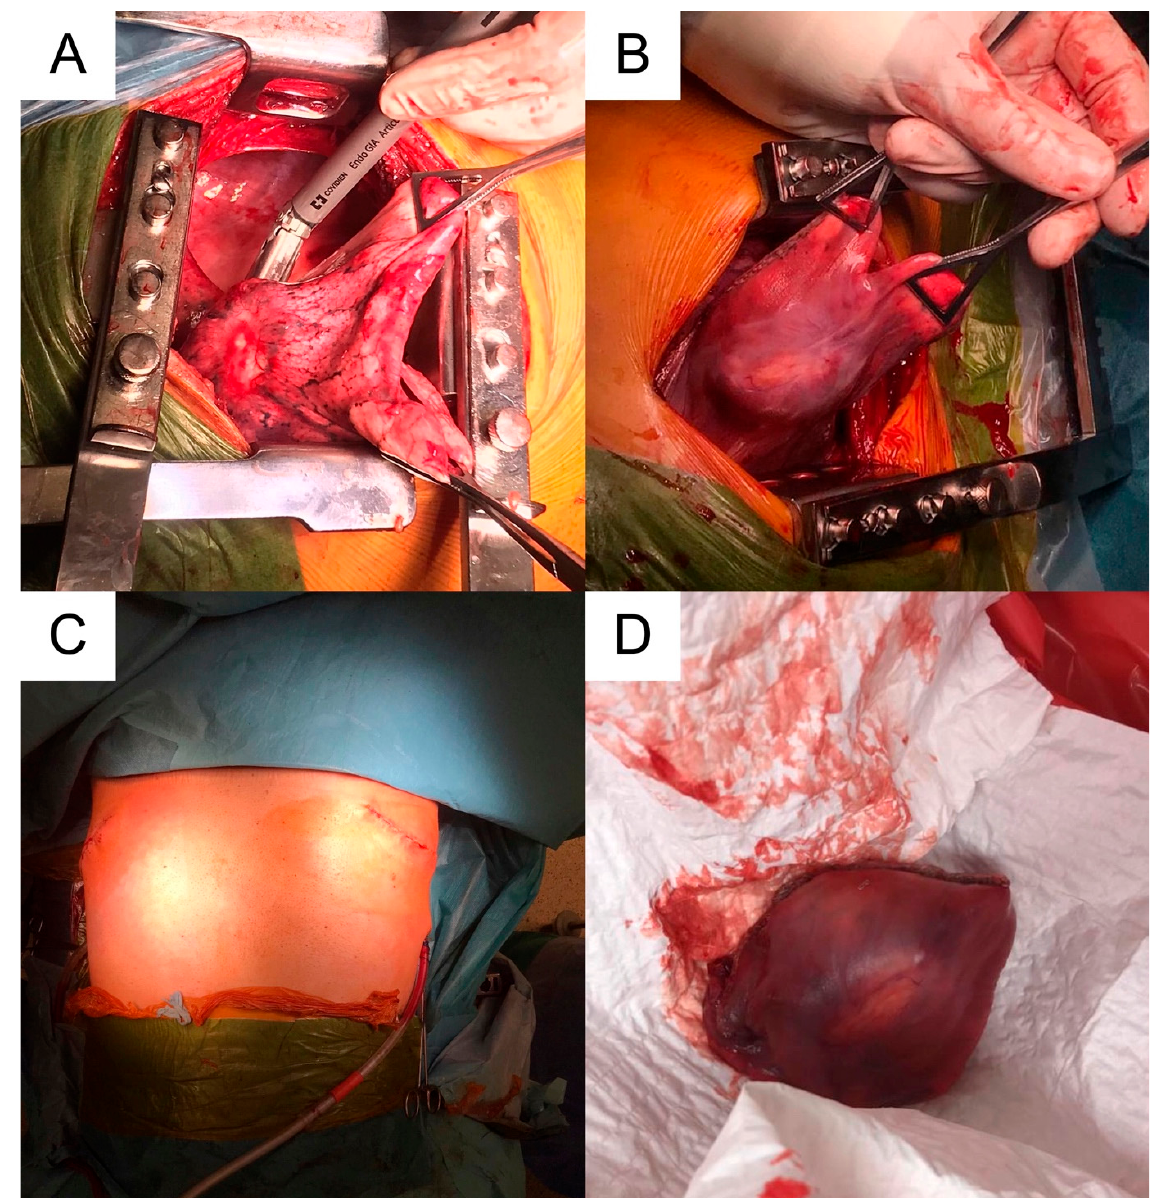
Figure 3. ( A , B ): Intraoperative snapshots of the wedge excisions; ( C ): prone position with simultaneous bilateral thoracotomies; ( D ): postoperative incisions and a typical specimen. In the presented case, the hepatic lesion ruptured directly to the right lower segmental bronchus S10 as confirmed acutely in a flexible bronchofibersocopy, where large amounts of purulent discharge were lavaged. Chest CT showed communication of the ruptured lesion with the large right airways (Figure 5). This acute respiratory situation required an urgent surgical procedure. The presence of pneumonitis precludes parenchymal resections. A thoracotomy for exploration and meticulous debridement was followed by formation of an open fenestration at the level of the 9th rib to control infection without parenchymal resection (Figure 6). Regular dressing changes and long-term anthelminthics controlled the infection (Figure